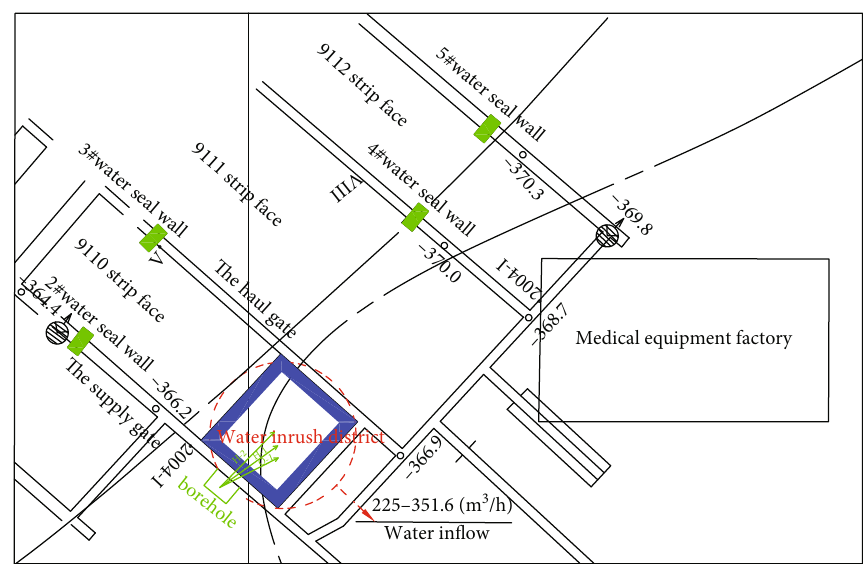
Figure 4: Map of the water inrush accident at the No. 9110 working